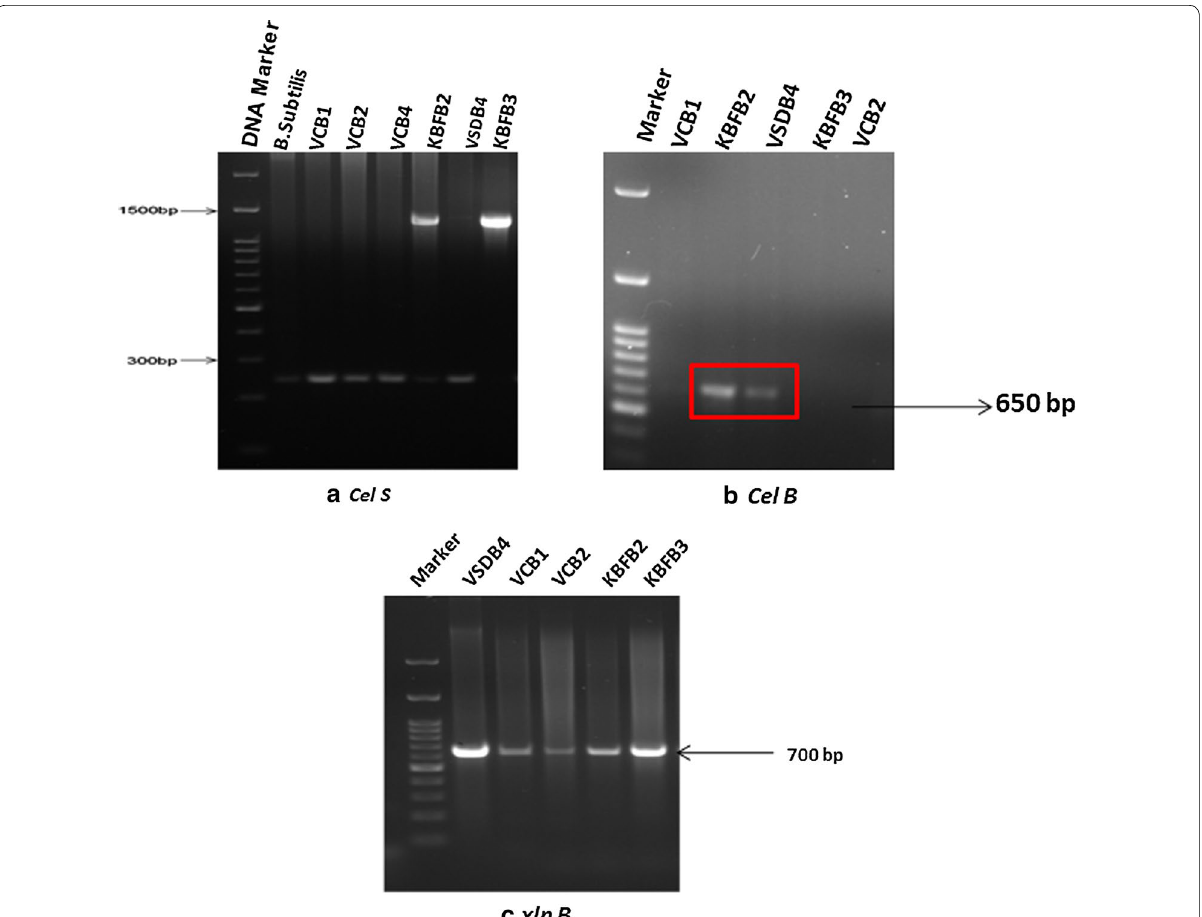
Fig. 4 PCR based confirmation of cellulolytic and xylanolytic activity by bacterial isolates. Further, the thermophilic bacterial isolates were confirmed for cellulolytic and xylanolytic activity using specific primers for cellulase (celS), cellulose binding domain (celB) and xylanase (xlnB). a Cel S b cel B c xln